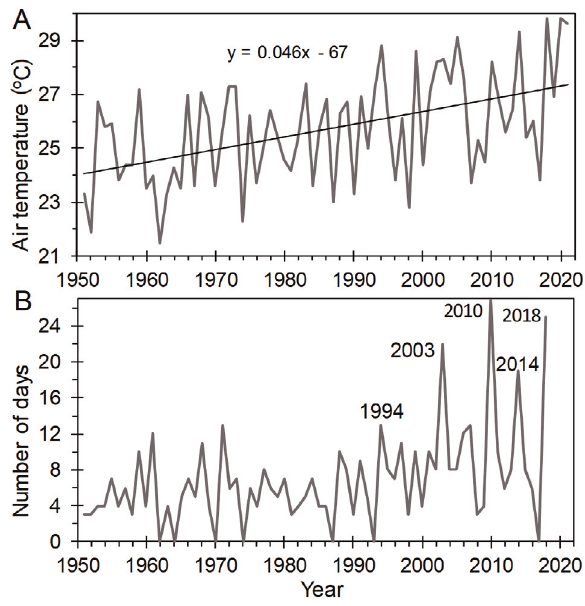
Fig. 2. Examples illustrating warming tendencies in Estonia over the last 70 years (updated from Õispuu 2019). A , annual maximum air temperatures with a (statistically significant) linear trend at Sõrve in 1951–2021. B , lengths of annual longest heat waves (>25 °C) at Viljandi in 1951–2018. Note that such long series are not instrumentally homogeneous (e.g. Keevallik & Vint 2012), which may artificially magnify the